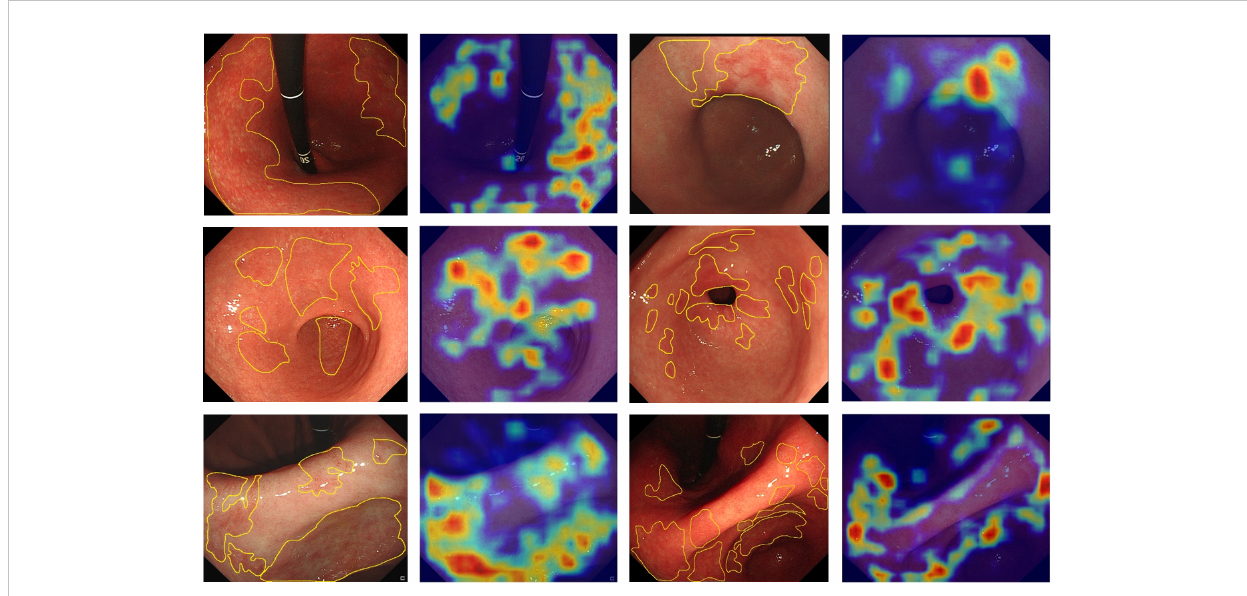
FIGURE 6 Feature heatmaps of the GAM-Ef fi cientNet. To improve the quality of the heatmaps, we cropped the original endoscopic image and did not compress